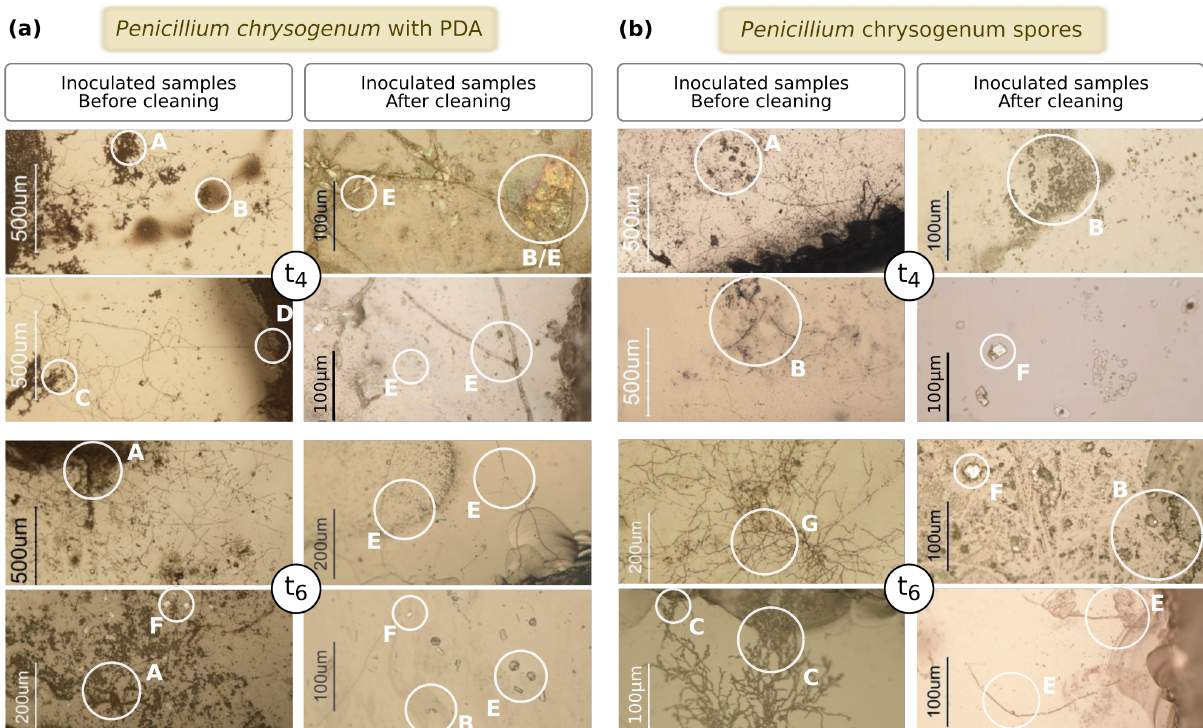
Figure A2. Optical microscopy results from the inoculation of SPB-87 with ( a ) Penicillium chrysogenum in PDA and ( b ) Penicillium chrysogenum spores in Tween solution. Legend as in Figure